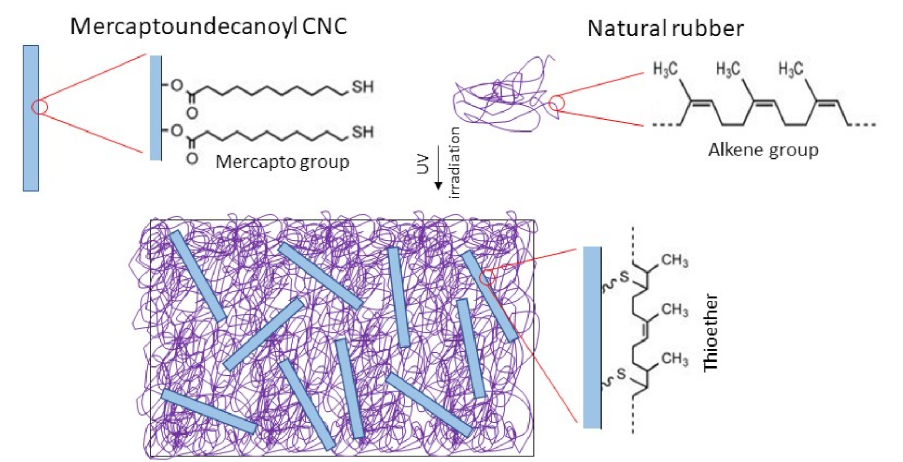
Figure 5. Illustration of the thiol-ene coupling reaction between natural rubber and modified cellulose nanocrystals in nanocomposite (adapted with permission from Kanoth et al. [34]. Copyright 2015 American Chemical Society, Washington, United